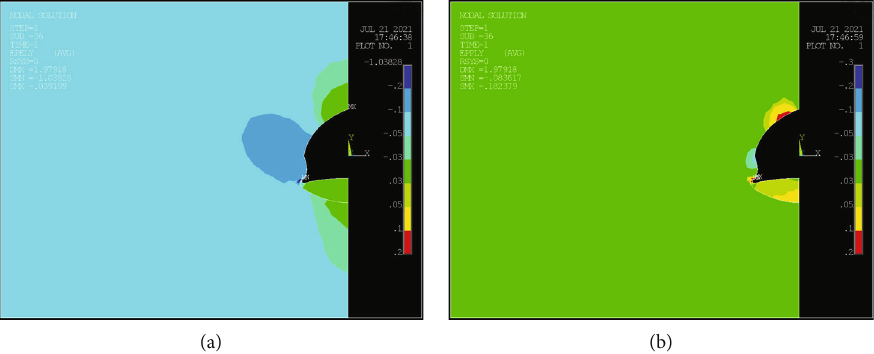
“ reinforced fl oor ” (elastic